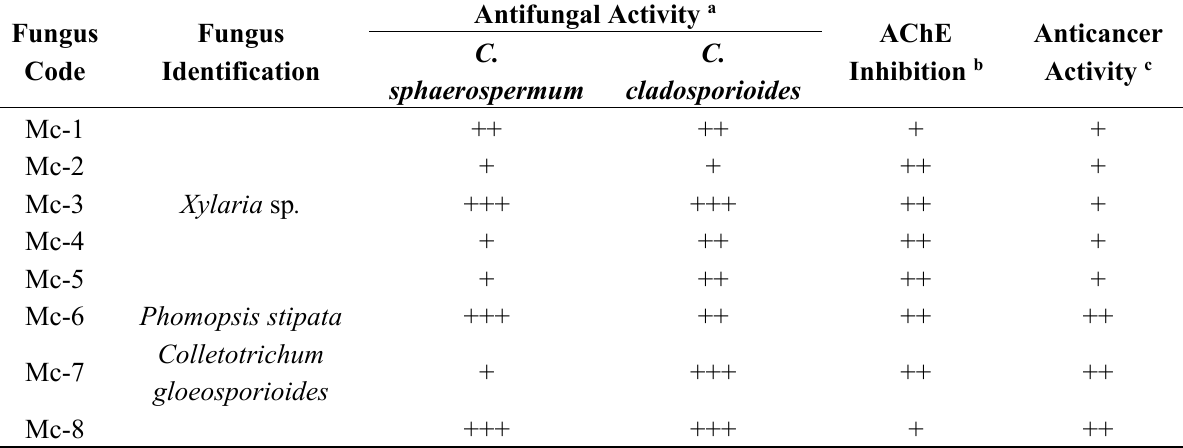
1. Biological activity evaluation of the endophytic fungi isolated